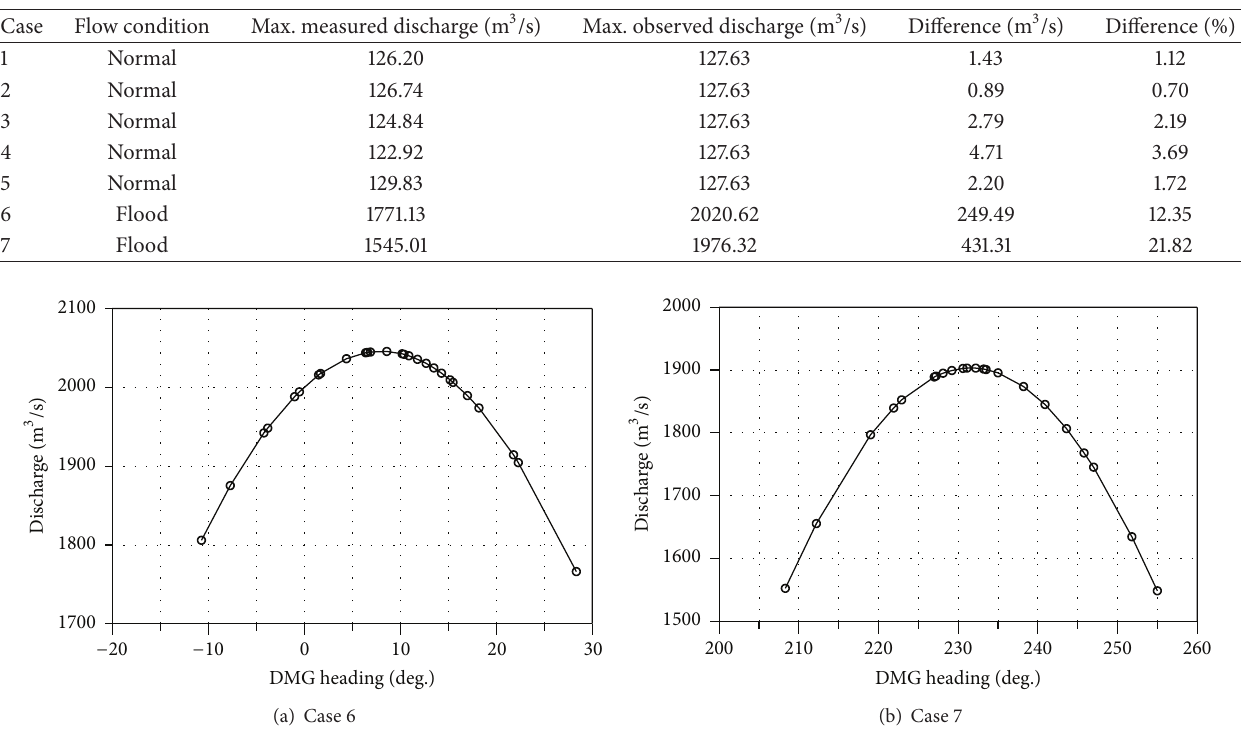
Figure 5: Discharge estimation using DMG heading